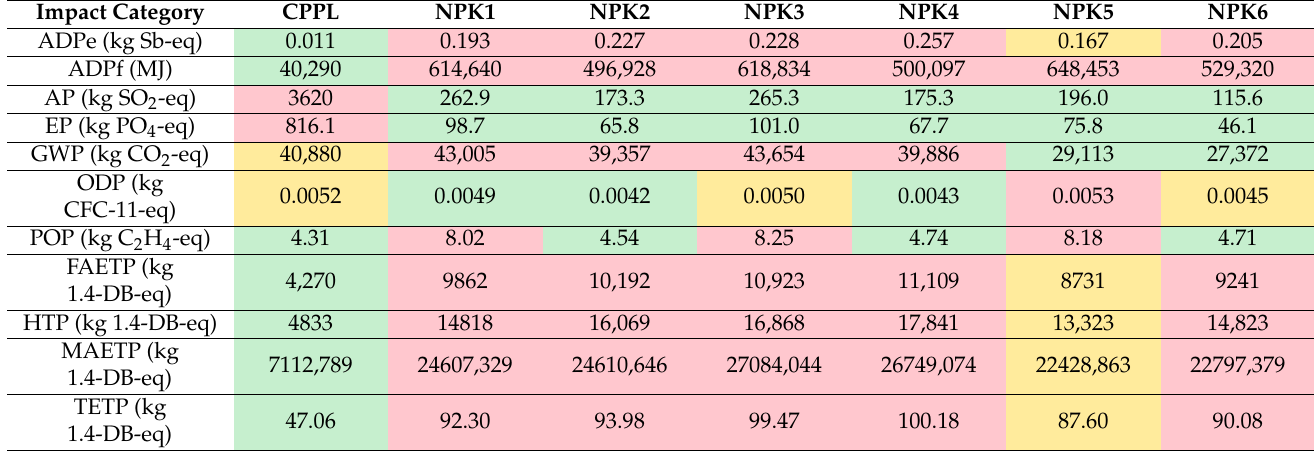
Table 11. Environmental emissions generated by the production of the applied CPPL and NPK treatments on 100 ha of arable